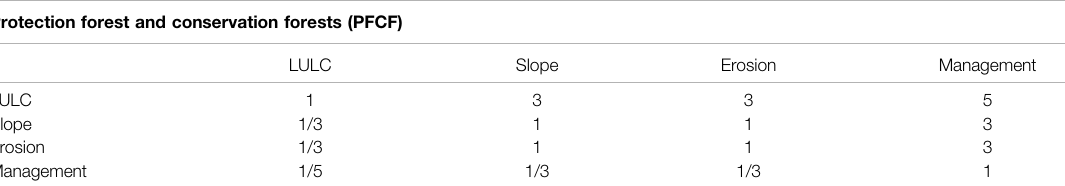
TABLE 1 | Calculating Criteria Weights with Consistency Ratio in the